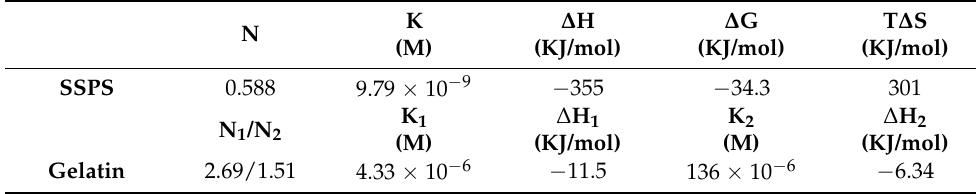
Table 1. Binding parameters for CP and